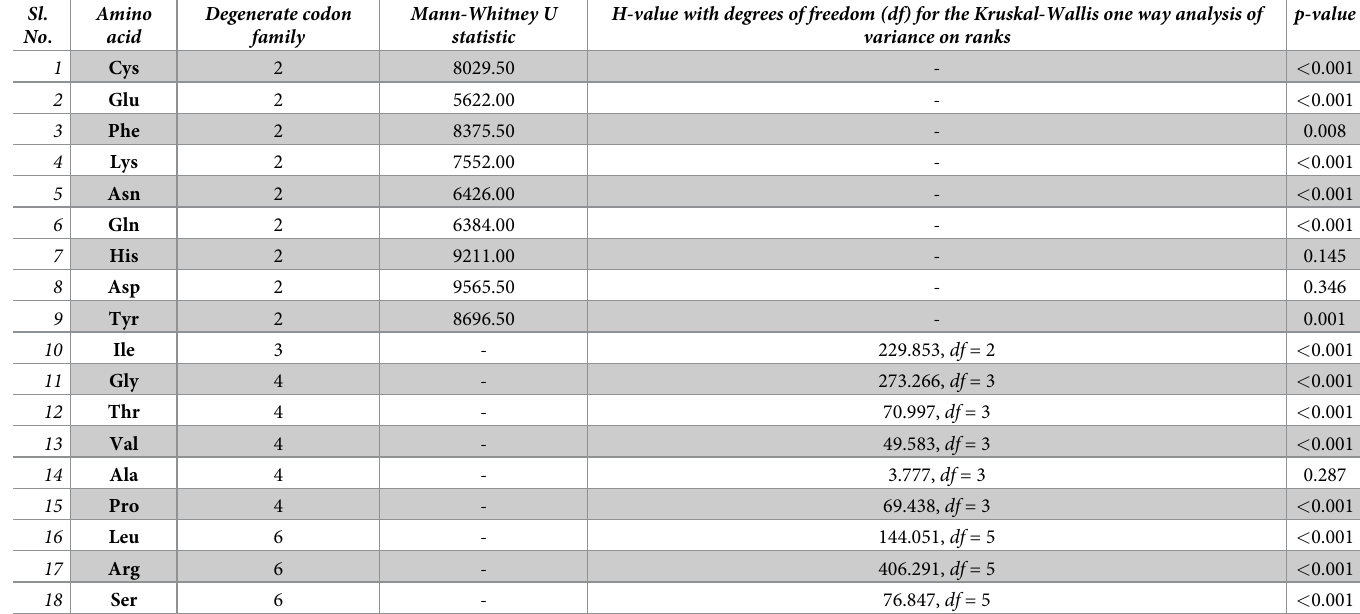
Table 1. Mann-Whitney U statistic and the H-value with degrees of freedom for the Kruskal-Wallis one way ANOVA on ranks on codon usage to detect ‘core’ set of codons used in structuring of ftsZ . Sl . No